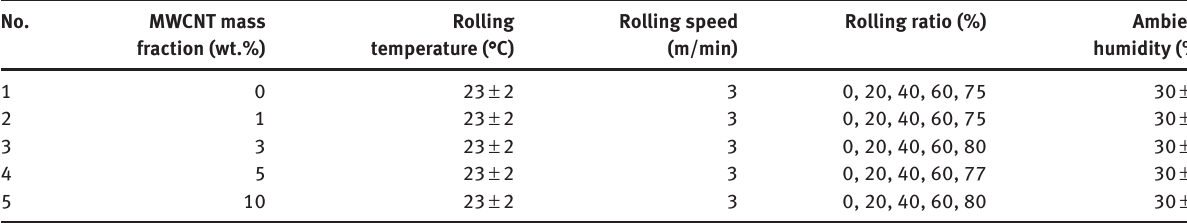
Table 1: Rolling process conditions for the fabricated composite sheets. No. MWCNT mass fraction (wt.%)